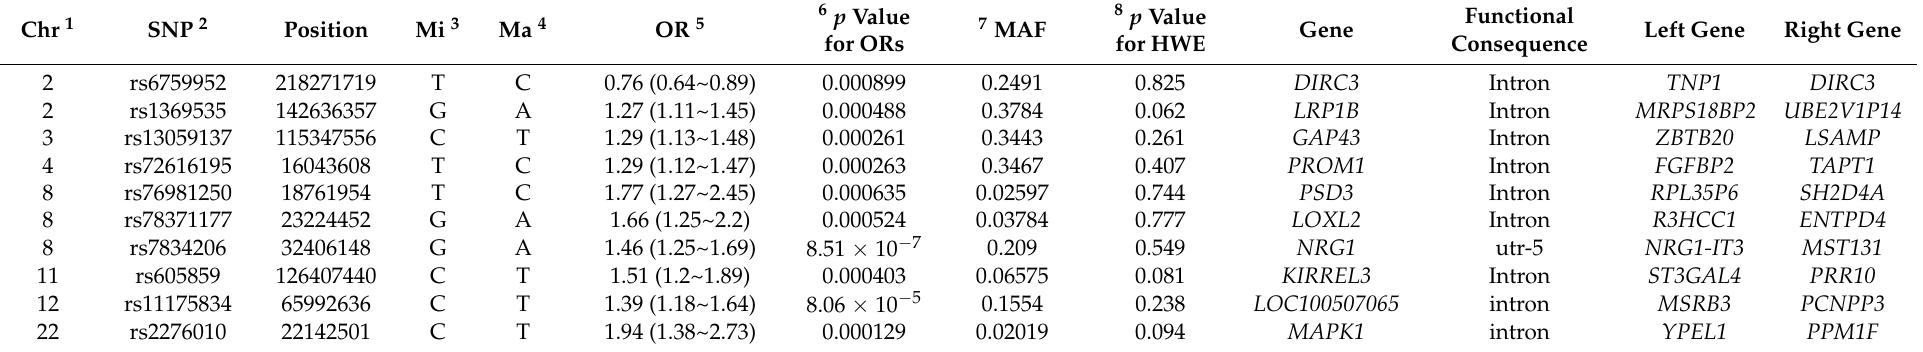
Table 3. The characteristics of the ten genetic variants of genes in thyroid cancer used for the generalized multifactor dimensionality reduction analysis.